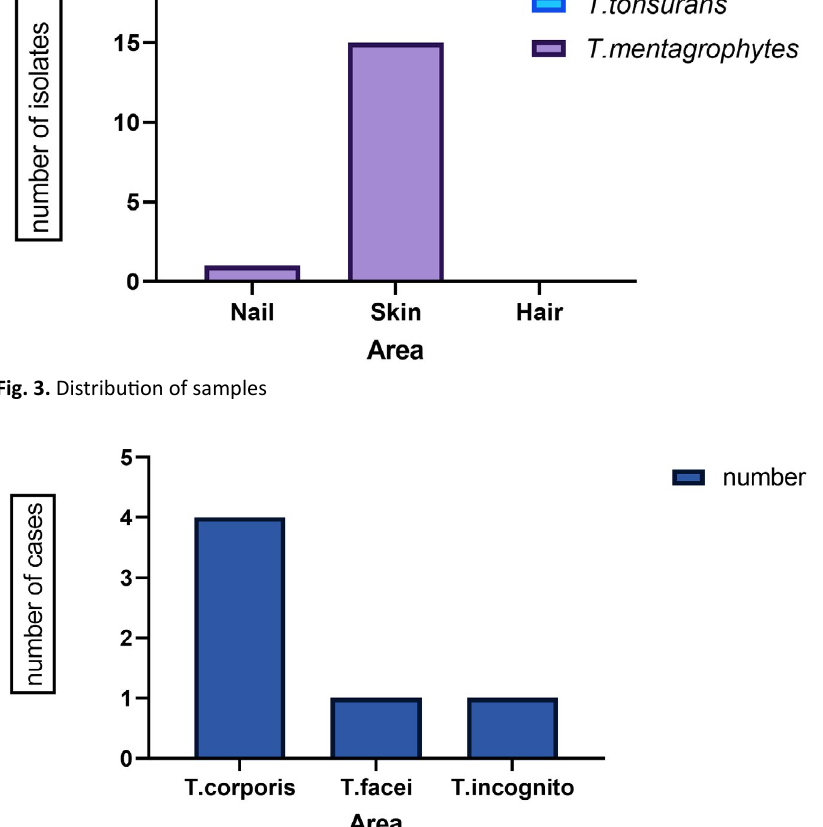
Fig. 4. Clinical type of dermatophytoses in present